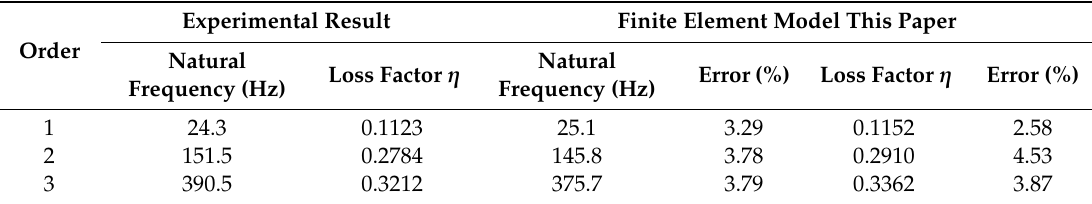
Figure 9. Experimental device for viscoelastic sandwich cantilever beam. Figure 10. Experimental device for viscoelastic sandwich cantilever beam. Table 4. Comparison of experimental results and finite element Table 4. Comparison of experimental results and finite element calculations.